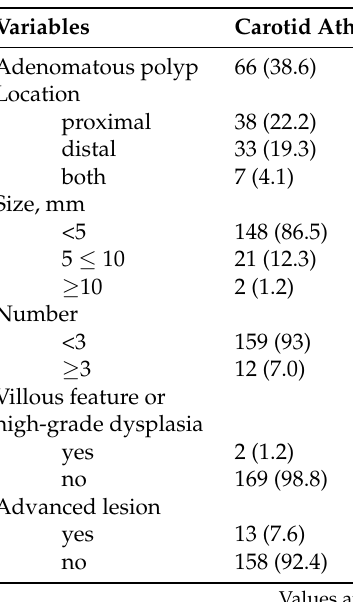
Table 2. Characteristics of colorectal adenomatous polyps according to carotid atherosclerosis.